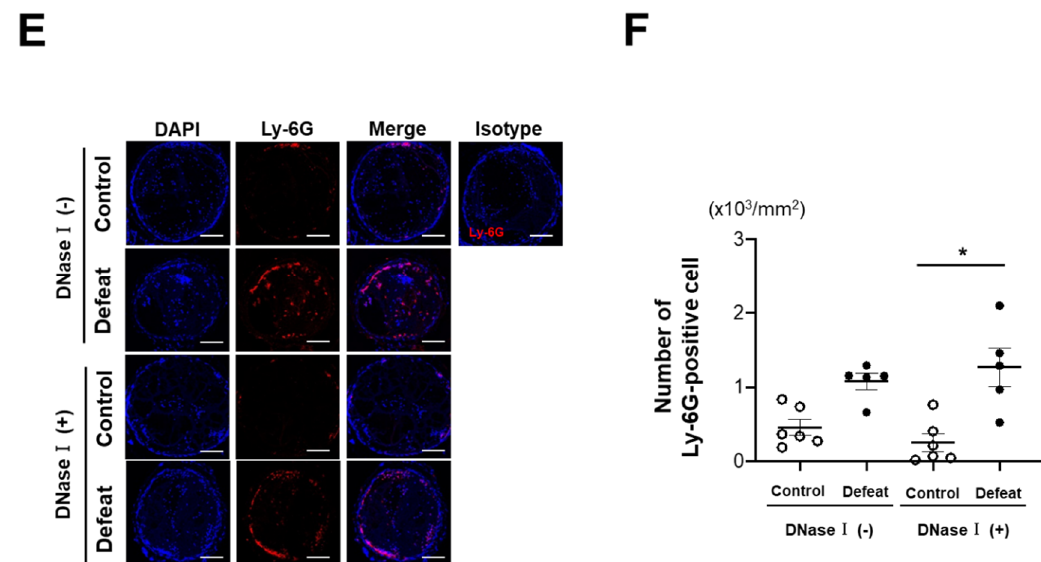
Figure 3. DNase I treatment completely inhibits augmented fibrin-rich clot formation in defeated mice. ( A , B ) Representative photographs of FeCl 3 -induced thrombus and quantitative analysis of the volume of thrombi in control and defeated mice with or without DNase I treatment. Scale bar = 100 μm. Values represent mean ± standard error of mean (SEM) for six control and five defeated mice without DNase I treatment and for six control and five defeated mice with DNase I treatment. ( C , D ) Representative fluorescent images of fibrin(ogen) and quantitative analysis of the percentage of fibrin(ogen)-positive area. Scale bar = 100 μm. Values represent mean ± standard error of mean (SEM) for six control and five defeated mice without DNase I treatment and for six control and five defeated mice with DNase I treatment. * p < 0.05 vs. control mice, # p < 0.05 vs. defeated mice; two-way ANOVA with the Tukey–Kramer post hoc test. ( E , F ) Representative fluorescent images of Ly-6G and quantitative analysis of the number of Ly-6G-positive cells. Scale bar = 100 μm. Values represent mean ± standard error of mean (SEM) for six control and five defeated mice without DNase I treatment and for six control and five defeated mice with DNase I treatment. * p < 0.05 vs. control mice with DNase I treatment; Kruskal–Wallis test.